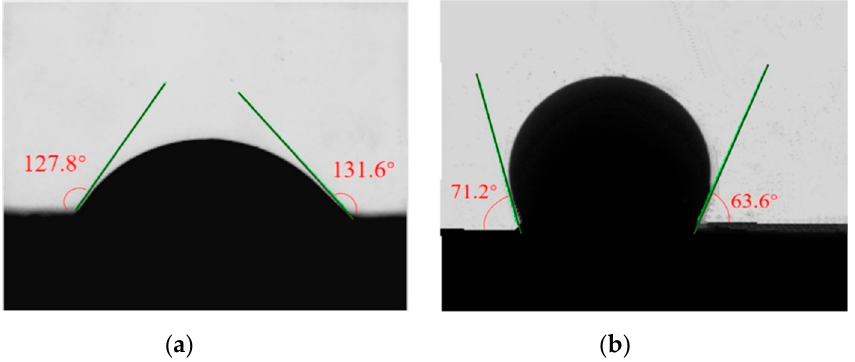
Figure 11. Contact angles of heavy oil on the surface of Tahe carbonate rock. ( a ) Without SDY-1. ( b ) With SDY-1.